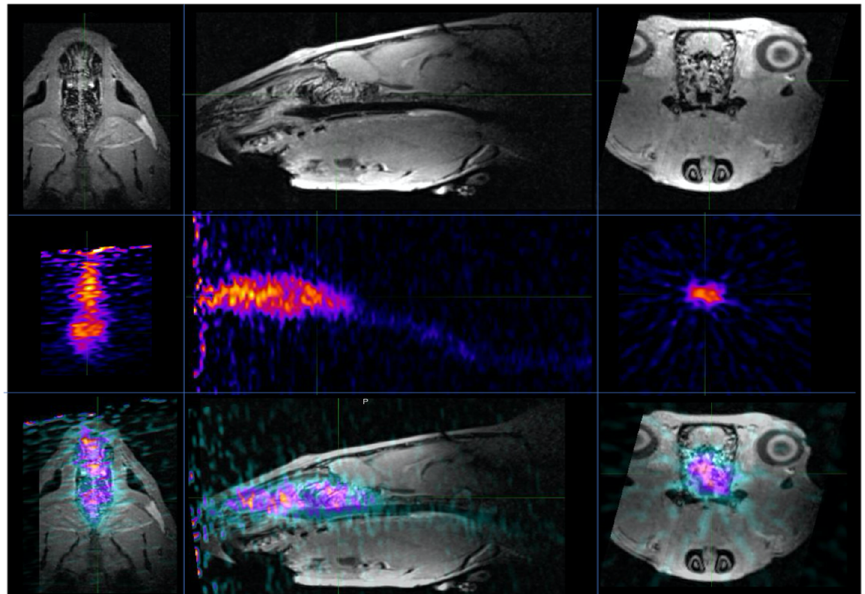
Figure 10. In vivo PET imaging of the aerosolized intranasal delivery. Horizontal, sagittal, and coronal images of a rat following an anatomic magnetic resonance imaging (MRI), functional 89 Zr PET, and MR/PET fusion. Radiotracer activity was distributed throughout the nasal cavity, with trace activity within the esophagus. Activity was not visualized above the background in the brain or lungs.